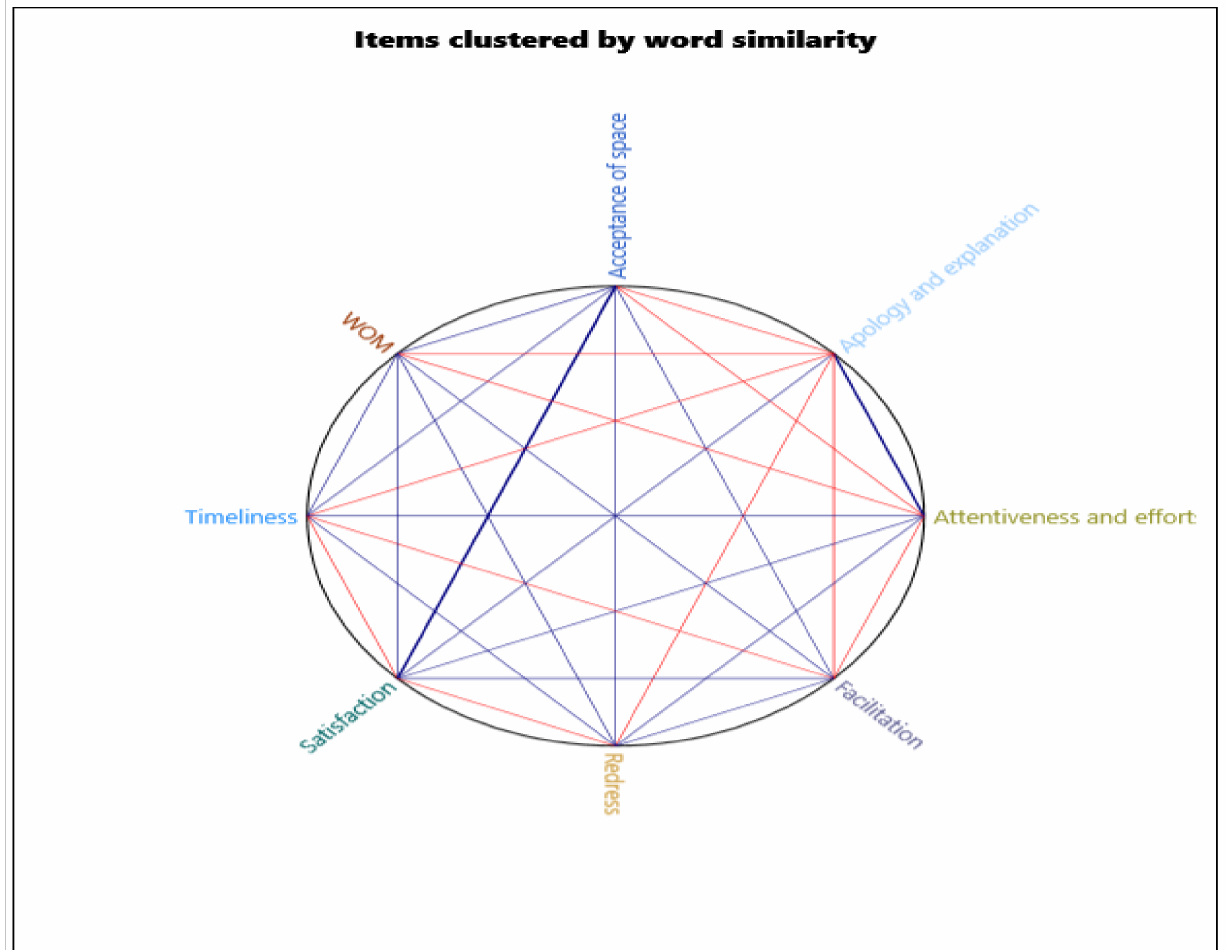
Figure 7. Word similarity of FM response dimensions and post-feedback